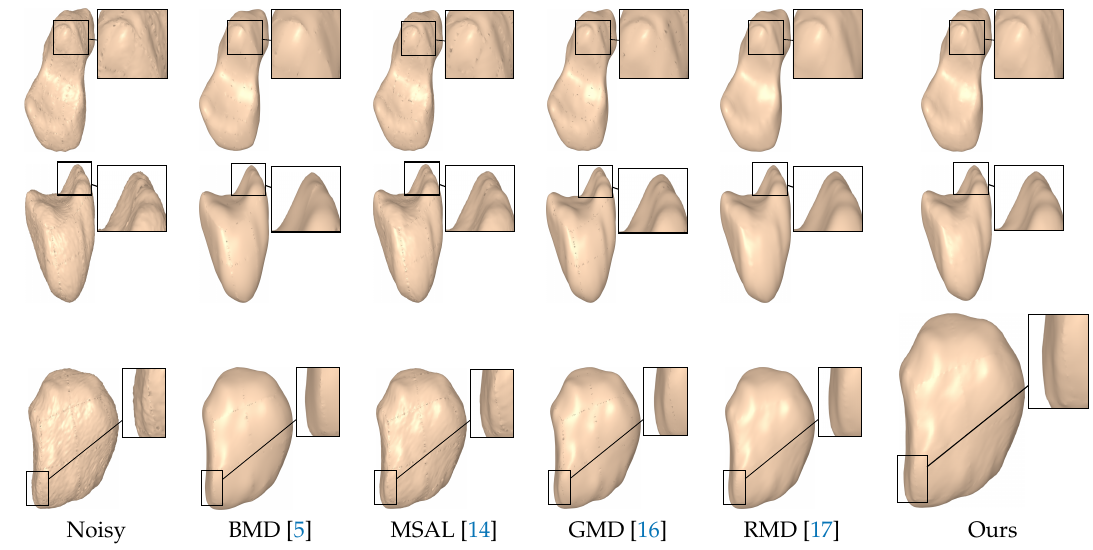
Figure 8. Surface denoising results for the noisy scaphoid, lunate, and pisiform models. The noise standard deviation was set to σ =